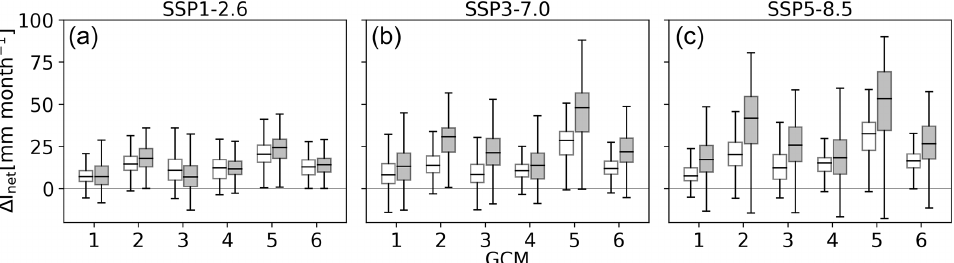
Figure 4. Spatial box plots of (cid:49)I net (mm per month) for the three SSPs (a–c) and five GCMs (1 to 5 – GFDL-ESM4, IPSL-CM6A-LR, MPI- ESM1-2-HR, MRI-ESM2-0, and UKESM1-0-LL) and the median across GCMs (6), for the near (2031–2060; white) and far (2071–2100; gray) future, both relative to the baseline period